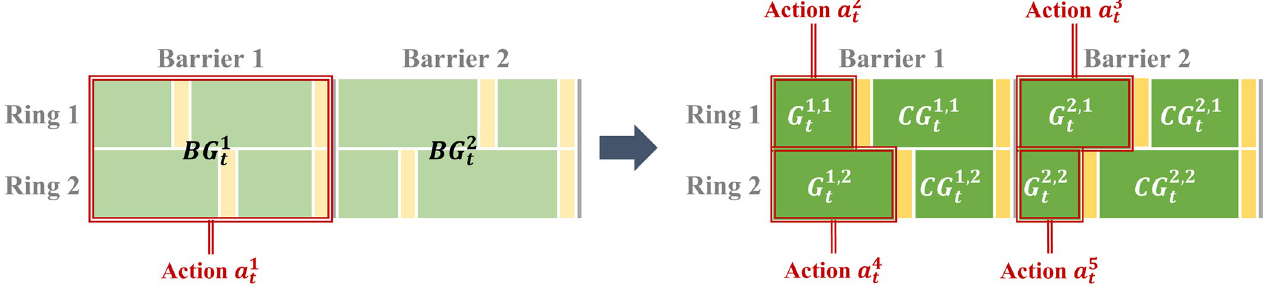
Fig 4. Method of splitting green time according to